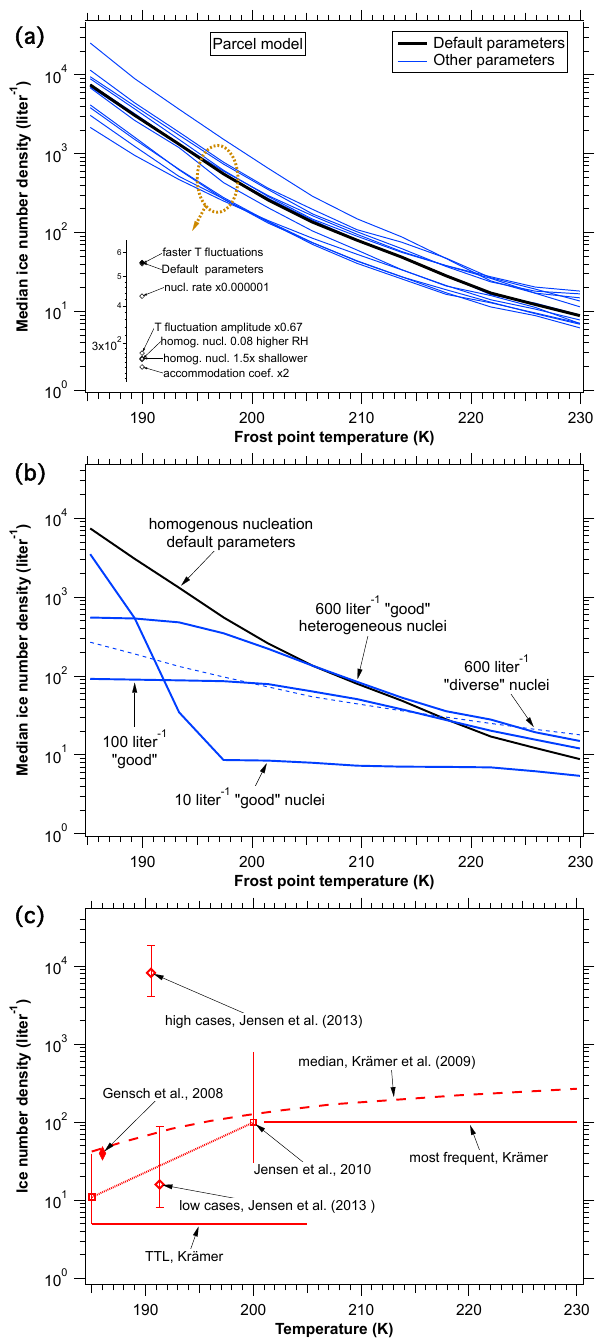
Figure 2. Parcel model results for the temperature dependence of ice crystal number density along with results from observations. In (b) , “good” heterogeneous nuclei freeze at an ice supersaturation of 1.3 ± 0.02, whereas “diverse” nuclei are uniformly distributed between supersaturations of 1.3 and 1.65. Panel (c) shows observa- tions described in Gensch et al., 2008, Krämer et al., 2009, Jensen et al., 2010, 2013b, and typical values from Krämer (personal com- munication, 2014). Ranges in (c) are approximated from the data in the Jensen et al. papers. In this temperature range, homogeneous freezing occurs about 3K below the frost point. TTL is the Tropical Tropopause Layer.